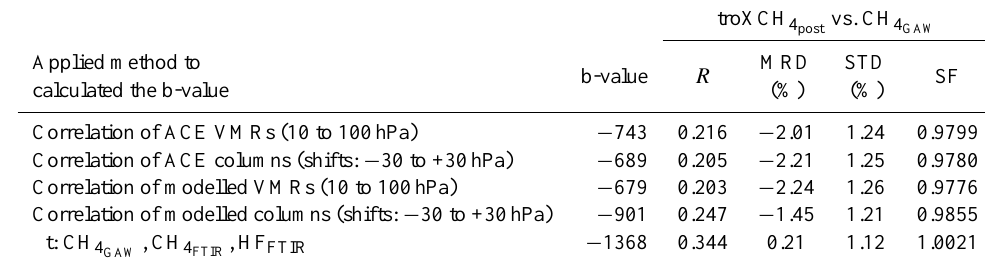
of the scaling retrieval. col